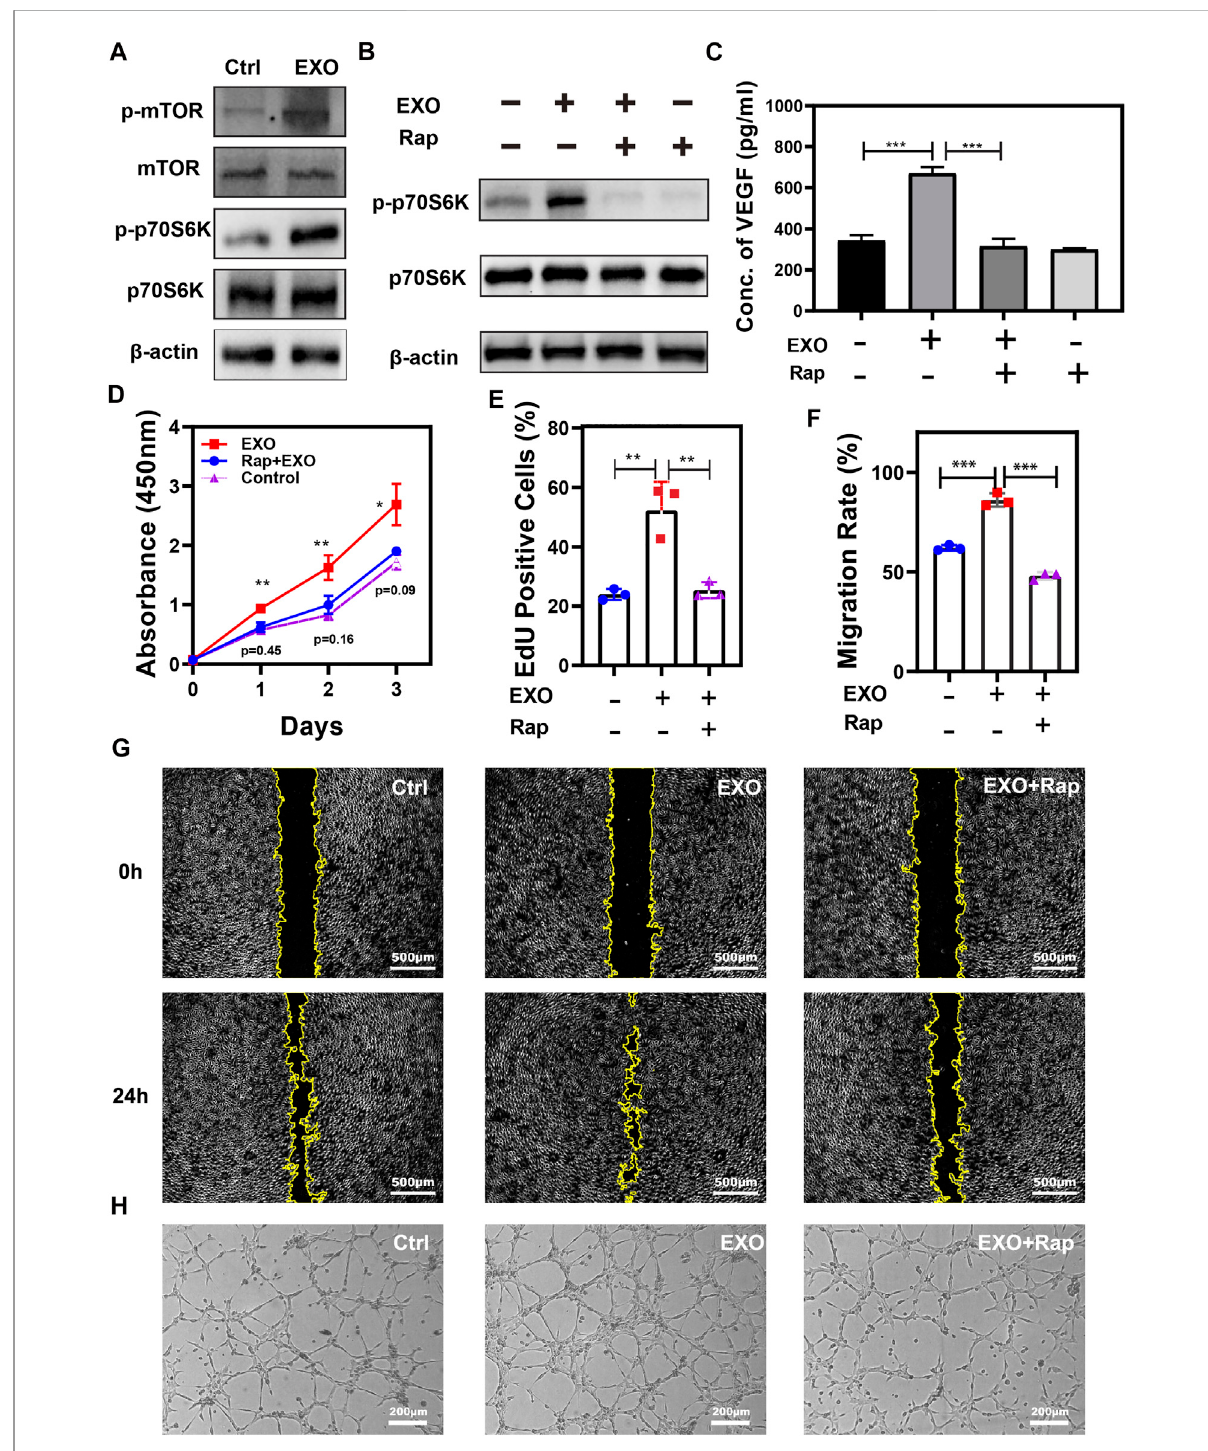
FIGURE 3 mTOR pathway participates in angiogenesis promotion induced by M2-EXO. (A) Western blot was used to test critical markers in the mTOR pathway. Treatment of M2-EXO increased phosphorylation of mTOR and p70S6K. (B) Western blot was used to test p-p70S6K expression. Rapamycin treatment counteracted the expression promotion of p-p70S6K induced by M2-EXO. (C) ELISA was used to test VEGF expression in Rapamycin treatment HUVEC culture medium. Treatment of Rapamycin counteracted the secretion promotion of VEGF inducedby M2-EXO. (D) CCK-8assaywasusedtodemonstratethepromotionroleofM2-EXOandthecounteractionroleofRapamycin.AfterM2-EXOtreatment,theviabilityof thecellswassharplyincreased,whileafterco-treatedwithRapamycin,theviabilityofthecellswasbarelyequaltothecontrolgroup. (E)